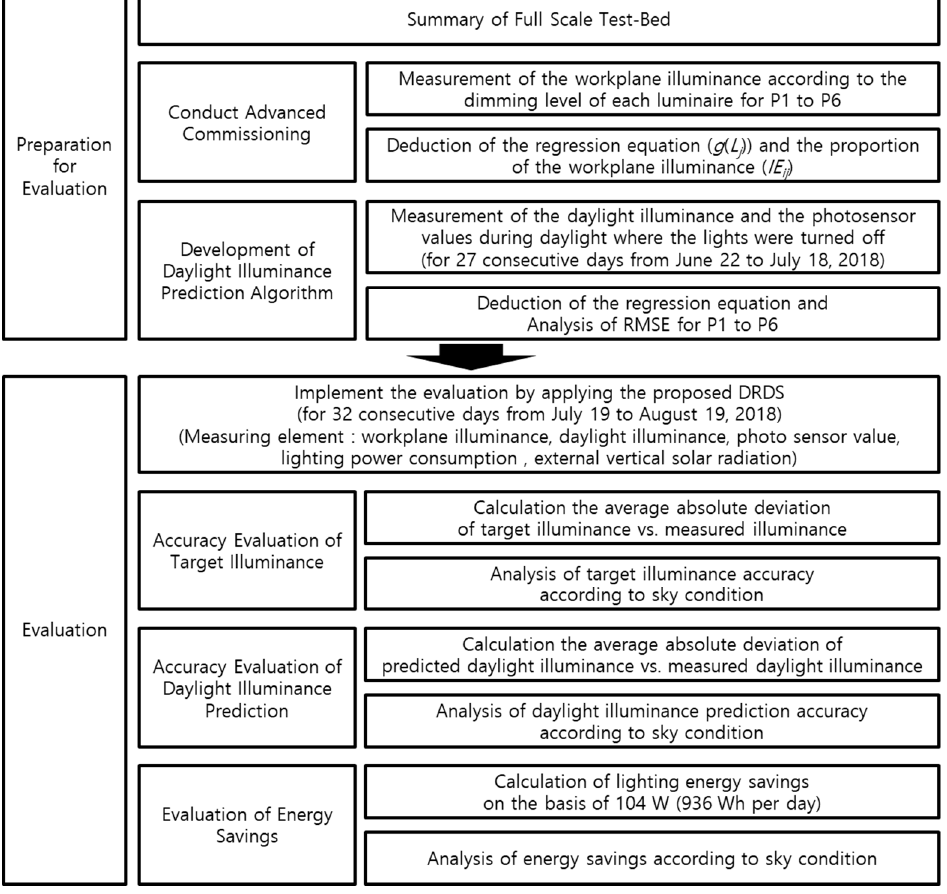
Figure 8. Flow chart of evaluation.